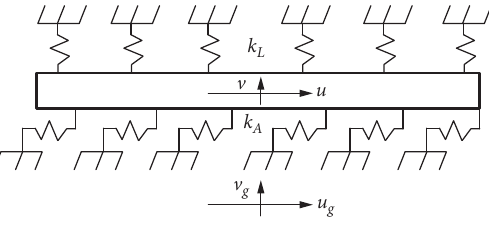
Figure 1: Elastic beam model for